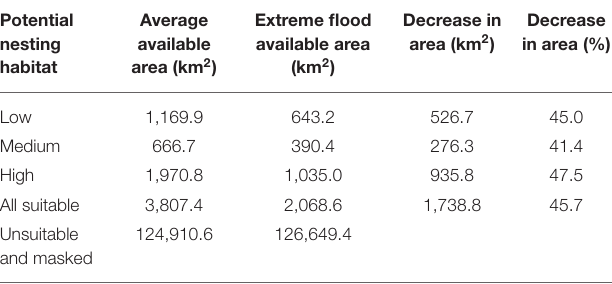
TABLE 1 | Average area of nesting habitat suitability and reduced area due to extreme flooding within the study